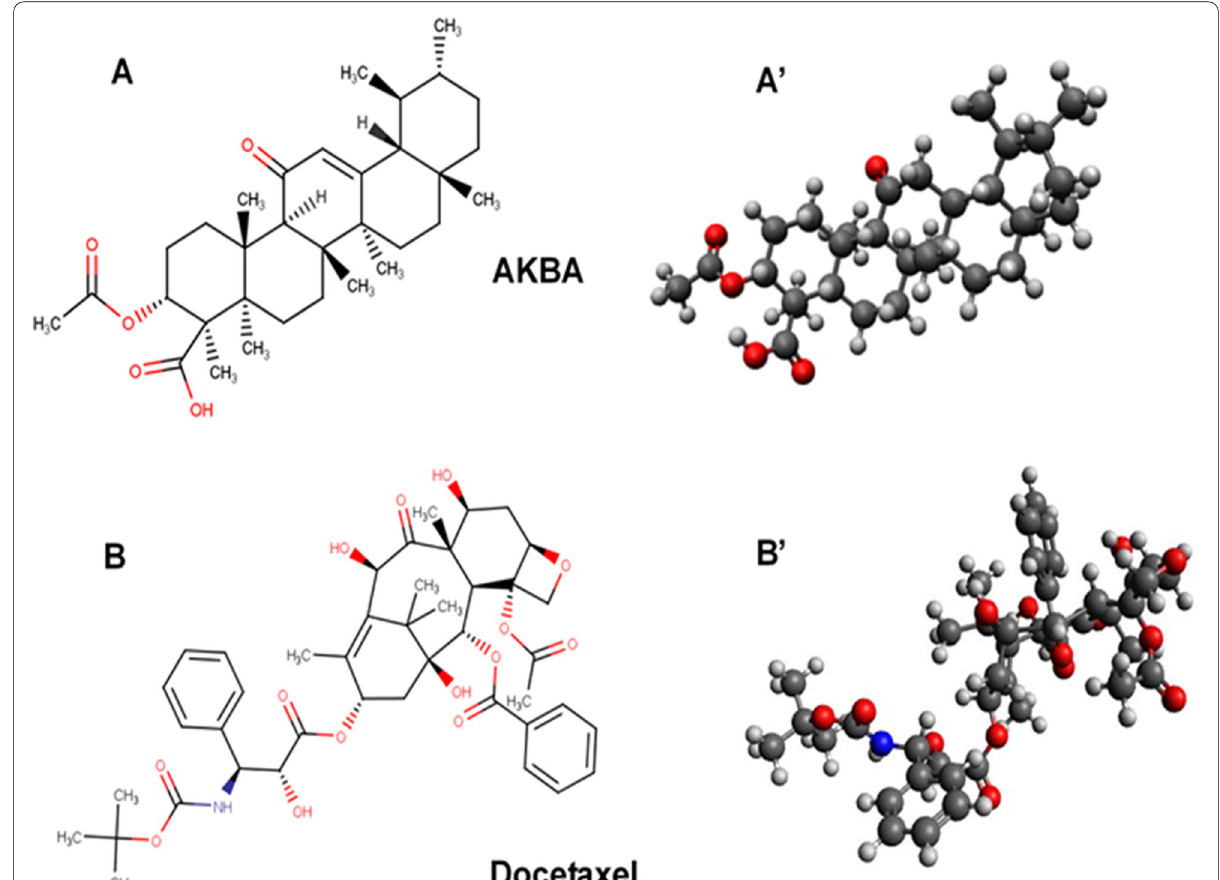
Fig. 2 2D and optimized structures of the test compound acetyl-11-keto-beta-boswellic acid (AKBA) ( A ) and the standard compound, docetaxel (TXL) ( B